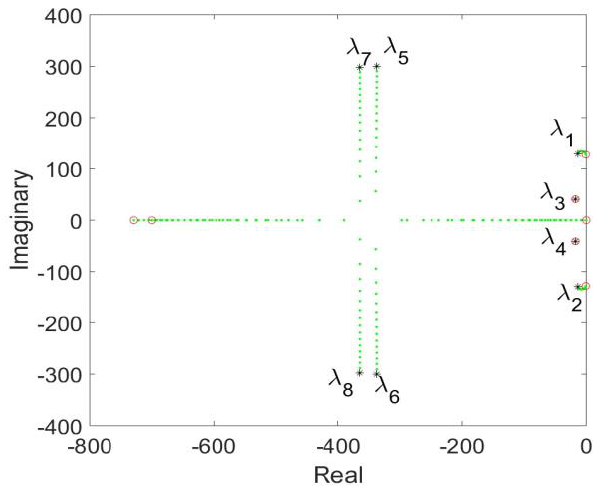
Figure 6. Eigenvalue loci of the system with k i 1 from 1 to 0.1.